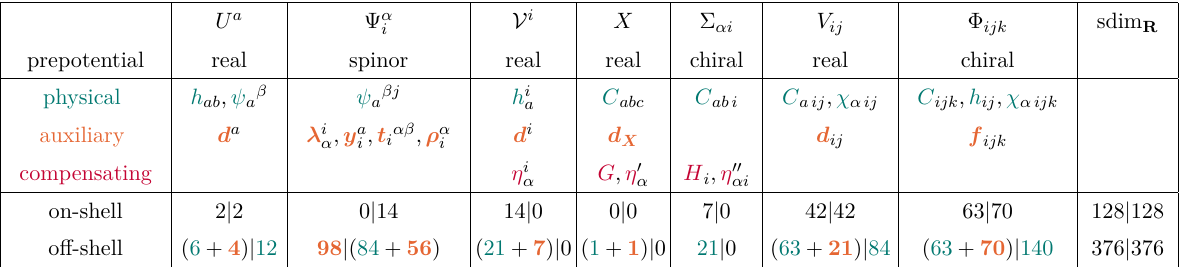
Table 3 . The unconstrained “prepotential” superfields of the 11D, N = 1 / 8 supergravity multi- plet and their physical, auxiliary, and compensating component content. The components of the gravitino of the type ψ iβ and ψ iβj are encoded in χ contributed by each superfield is computed modulo gauge transformation. The superdimension of the auxiliary field space adds up to 201 | 56